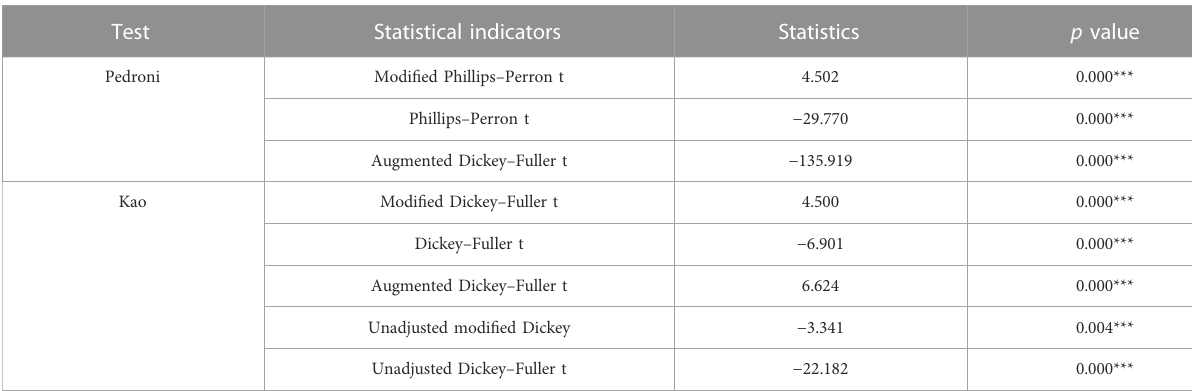
TABLE 5 Co-integration test.